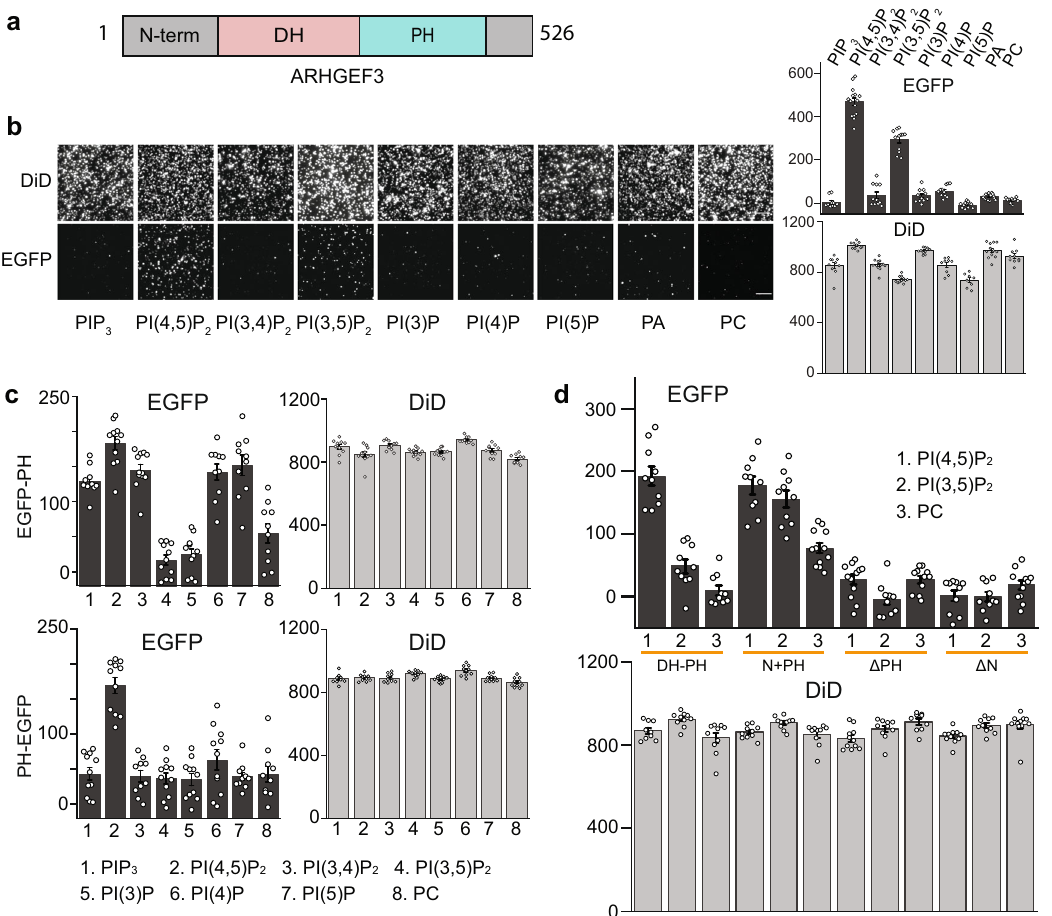
Fig. 3 Domain analysis of ARHGEF3 binding to PI(4,5)P 2 and PI(3,5)P 2 . a Schematic diagram of ARHGEF3 domain structure. b HEK293 cells were transiently transfected with EGFP-ARHGEF3, and the lysates were subjected to SiMPull assays against various types of lipid vesicles as indicated. Representative TIRF images are shown. Scale bars: 5 µ m. Numbers of fl uorescent molecules per image area are shown in the graphs on the right. Each assay was performed with at least three independent transfections with similar results. c Similar to ( b ), ARHGEF3 PH domain tagged by EGFP at N- or C- terminus was assayed for binding to seven types of PIP vesicles and PC control vesicles. d Similar to ( b ), various EGFP-tagged ARHGEF3 fragments were assayed for binding to vesicles containing 5% PI(4,5)P 2 . DH-PH: aa125 – 455; N + PH: aa1-125 + aa320-455; Δ PH: aa304-466 deleted; Δ N: aa118 – 526. All data in graphs are presented as mean ± SEM. N ≥ 10 images for EGFP; N ≥ 6 images for DiD. Source data are provided as a Source Data fi le, which lists the exact N number for each data point. Each assay was performed with at least three independent transfections with similar